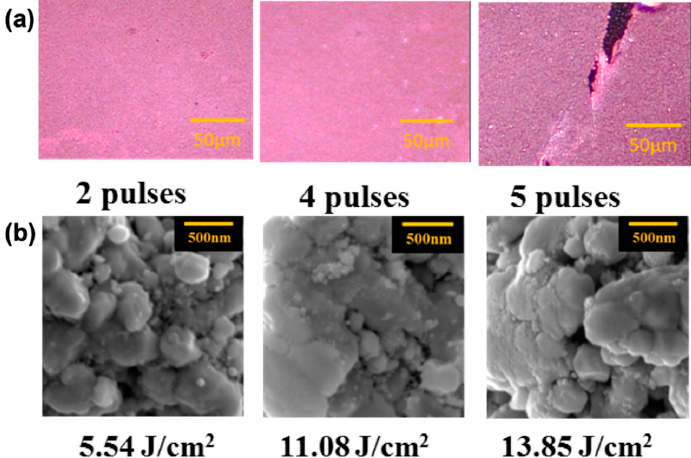
Figure 5. Optical ( a ) and scanning electron microscope (SEM) ( b ) images of sintered copper films by multiple pulses. Each single pulse has an energy density of 2.77 J/cm 2 .